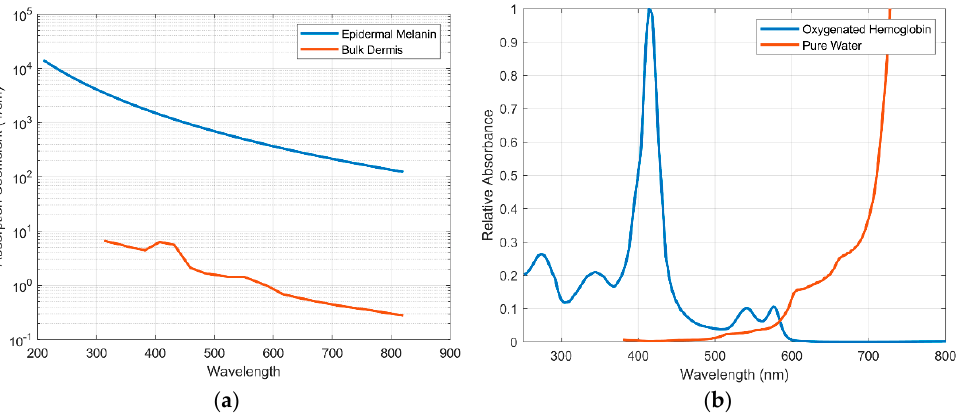
Figure 3. ( a ) Absorption coefficient of epidermal melanin vs. bulk epidermis. ( b ) Optical absorption of oxygenated hemoglobin and water [47–50].